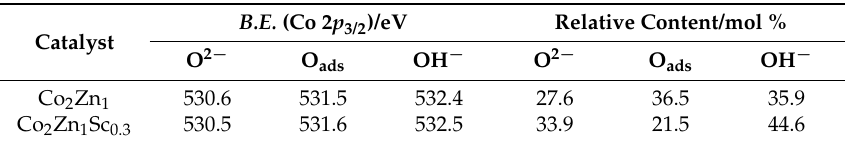
Table 3. XPS binding energy and relative content of the O-species with different valence states at the surface of the catalysts.